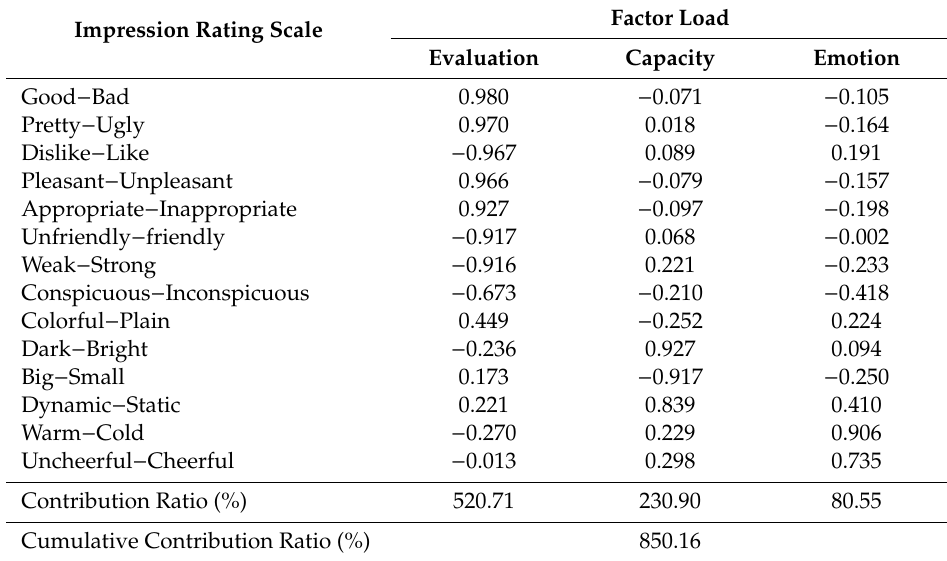
Table 7. Factor load for